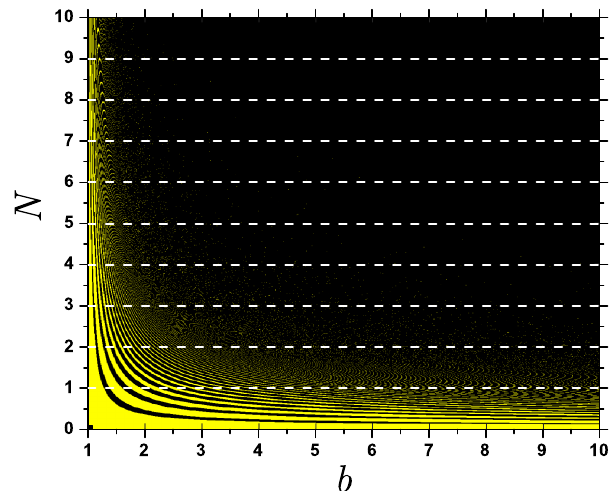
Figure 13. Difference between the exact number of collisions (13) and the approximation (14), which relates it to the digits of pi, as a function of base b and mantissa N . Two possible values are denoted with the dark (0) and light (1)